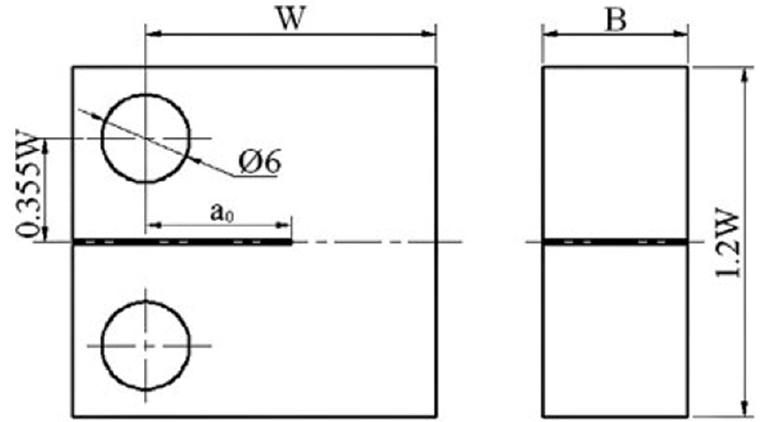
Figure 3. The geometry of the CT specimen (mm).